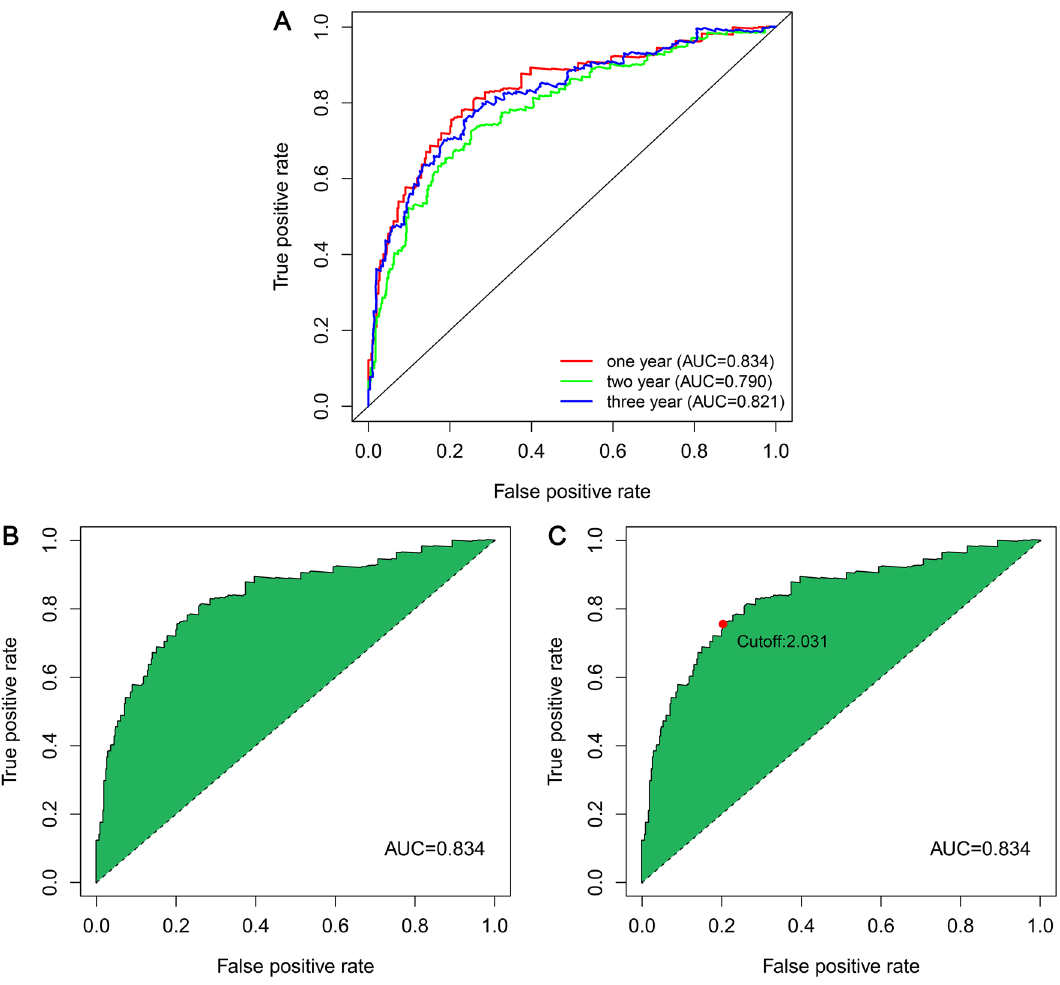
Figure 4. The curves of ROC were obtained after the determination of the risk coefficient model based on necroptosis-related lncRNA pairs of LUAD. ( A ) The model was used in obtaining ROC curves during the periods of 1 year, 2 years, as well as 3 years. The values for AUC were greater than 0.790. ( B ) A ROC curve of one-year containing the highest value of AUC was established with the aid of the model. ( C ) 2.031 was the cut- off value, which differentiates between high- and low-risk patients using the best